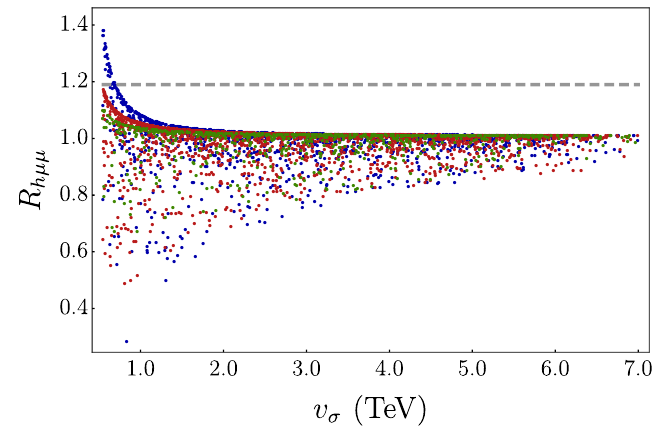
Figure 5 . R hµµ as a function of v σ for three fixed values of the vector-like mass M F : M F = 1 TeV (blue), M F = 3 TeV (red) and M F = 5 TeV (green). The horizontal line represents the current central value, R hµµ = 1 . 19